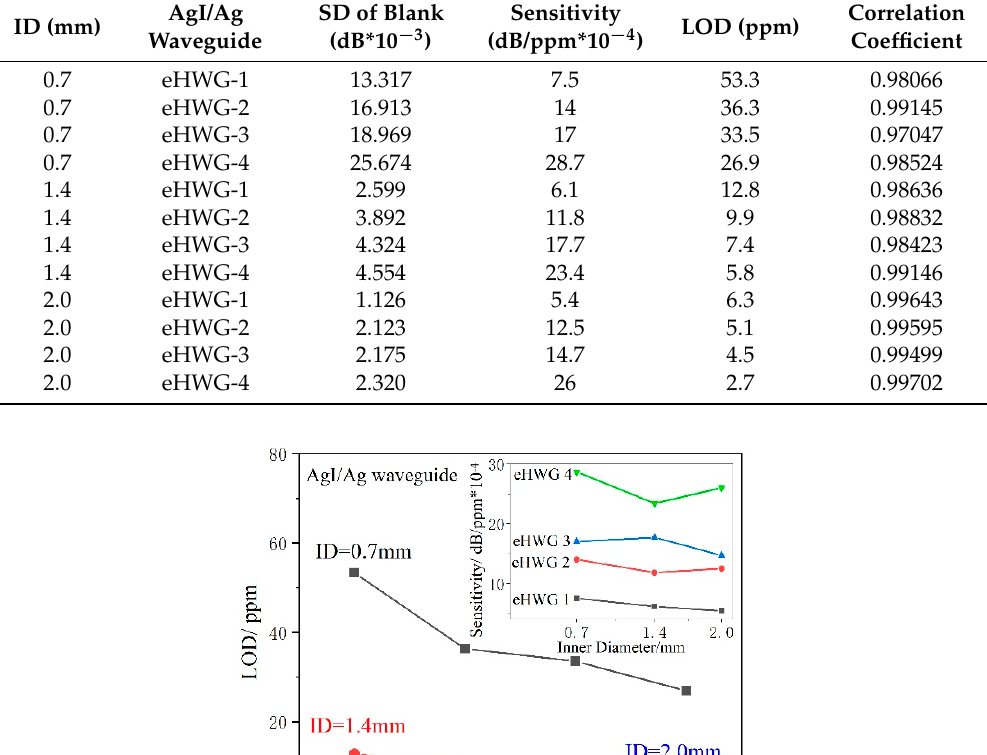
Table 3. Summary of the performance of different IDs.